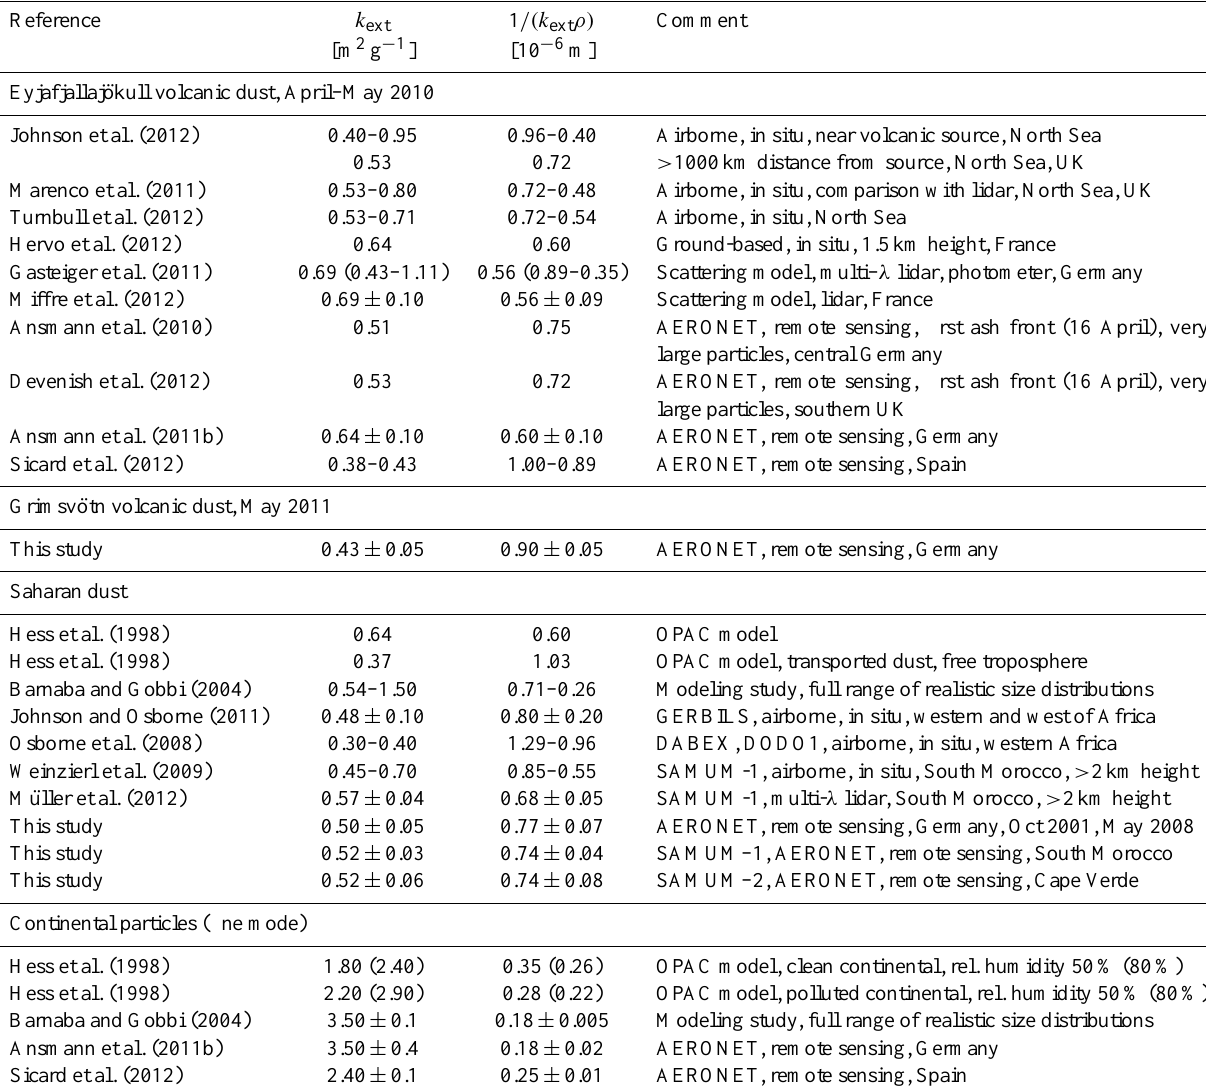
Table 2. Overview of recently observed mass-specific extinction coefficients k ext = σ ext /(ρV ) for volcanic and desert dust aerosols. In addition the ratio of frequently measured volume concentration to volume extinction coefficient V/σ ext = 1 /(k ext ρ) is given. A few modeled values (Hess et al., 1998; Barnaba and Gobbi, 2004) for coarse-mode as well as for fine-mode particles are added. Values are taken from the indicated literature (reference). Saharan dust mass-specific extinction coefficients (mean values for the vertical tropospheric column) computed from AERONET sun-sky photometer observations at Leipzig, Germany, Ouarzazate, Morocco, and Praia, Cape Verde, are included (indicated by: this study). The mass-specific extinction coefficients hold for a coarse-mode particle density of ρ c = 2 . 6gcm − 3 (desert and volcanic dust), fine-mode particle density of ρ f = 1 . 6gcm − 3 , and particle extinction coefficients for the 500–550nm wavelength range. Mean values and/or the range of observed values are given. Hervo et al. (2012) derived mass-specific extinction coefficients for volcanic dust without assumptions of particle mass density.